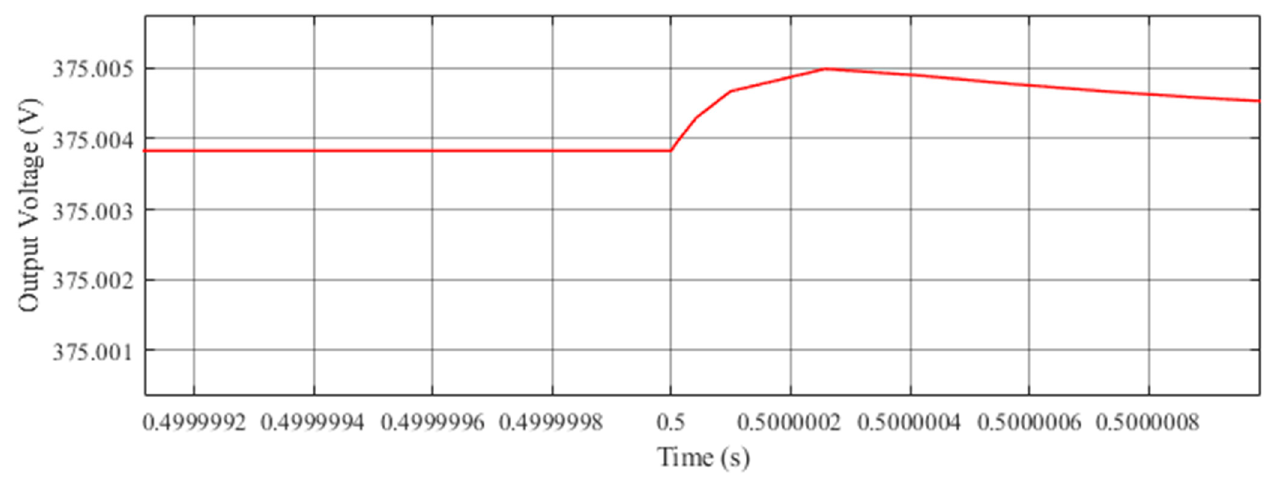
Figure 7. Output voltage of system by nonlinear integral backstepping (NLIB) controller in d - q frame.